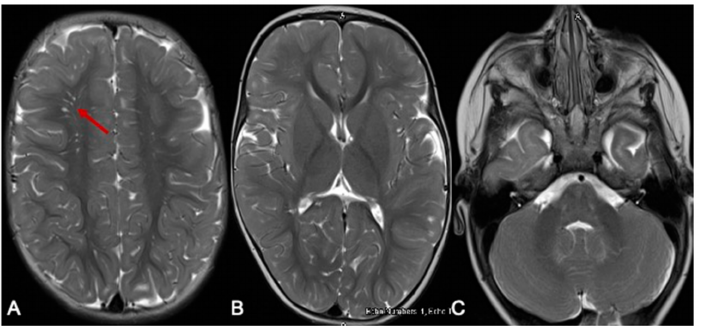
Figure 2. MRI of the brain 10 months later. The red arrow indicates the prominent perivascular spaces. From a follow-up MRI brain scan 10 months later, the T2-weighted axial images show significant improvement in myelination. Prominent perivascular spaces are also seen ( A -arrow). There is resolution of the previously noted signal changes of basal ganglia and thalamus ( B ), and the brainstem and dentate nuclei ( C